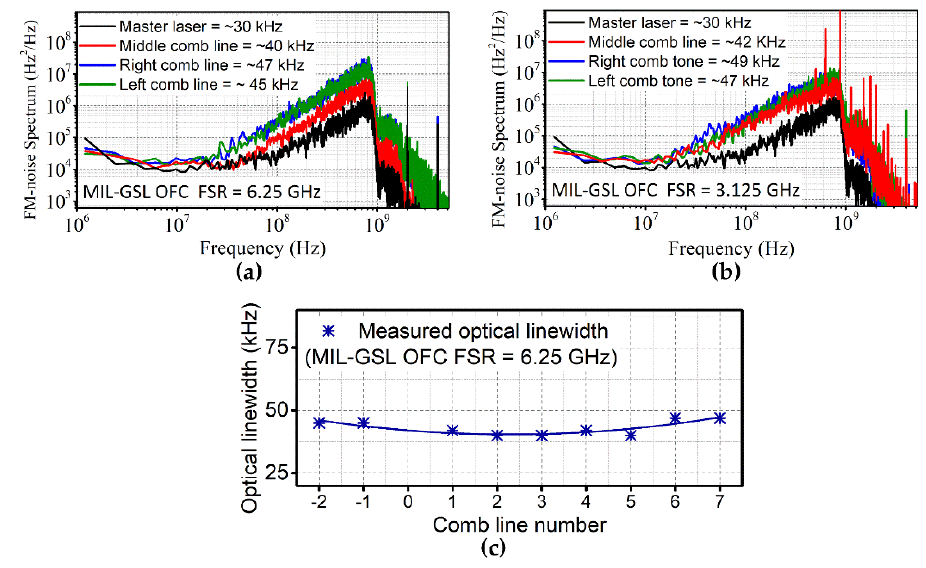
Figure 6. FM noise spectrum for MIL-GS OFC lines at FSR of ( a ) 6.25 GHz; ( b ) 3.125 GHz; ( c ) plot of measured optical linewidths of different comb tone (FSR = 6.25 GHz).